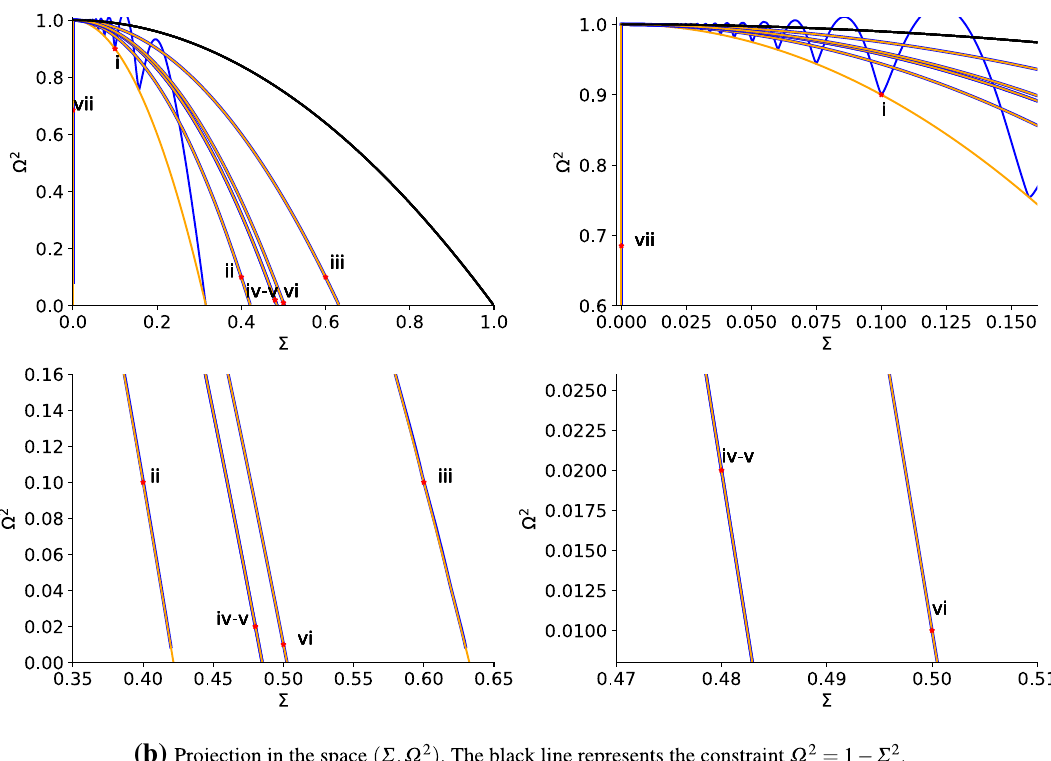
Fig. 6 Some solutions of the full system (44) (blue) and time-averaged system (72) (orange) for Bianchi I metric when γ = 2. We have used for both systems the initial data sets that are presented in Table